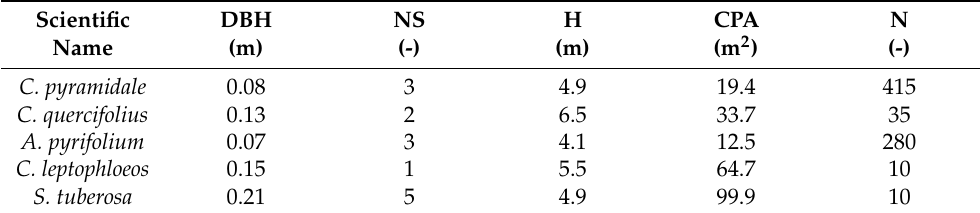
Table 1. Main characteristics of the tree species used in the rainfall interception measurement: number of individuals (N), average diameter at breast height (DBH), average number of stems (NB), average tree height (H) and average tree crown projected area